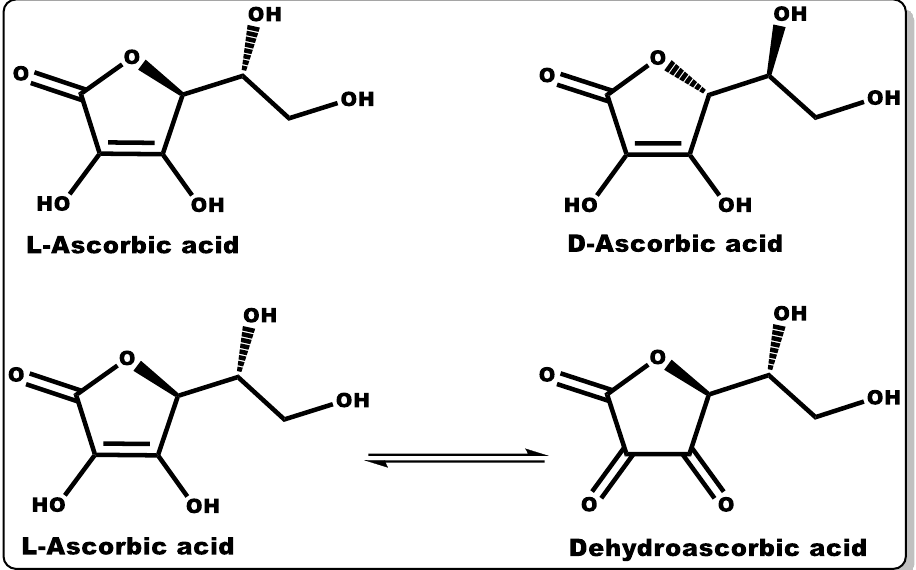
Figure 8. Molecular structures of ascorbic acid and its oxidised form.